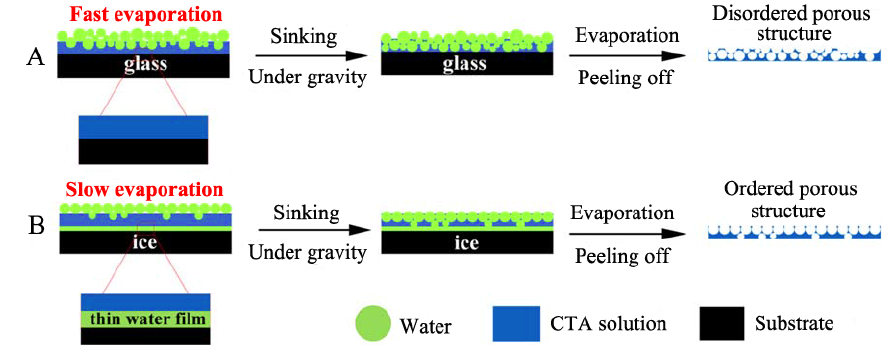
Figure 7. Comparison of the porous structure formation on glass ( A ) and ice ( B ) substrates, with copyright permission from [88].